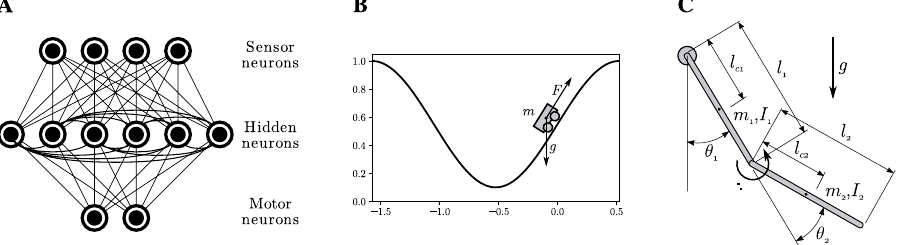
Figure 3. ( A ) Structure of the embodied neural controller for a model with N = 12 units and N h = 6 hidden units. ( B ) Mountain Car environment: an under-powered car that must drive up a steep hill by balancing itself to gain momentum. ( C ) Acrobot environment: an agent has to balance a double pendulum to reach the high part of the